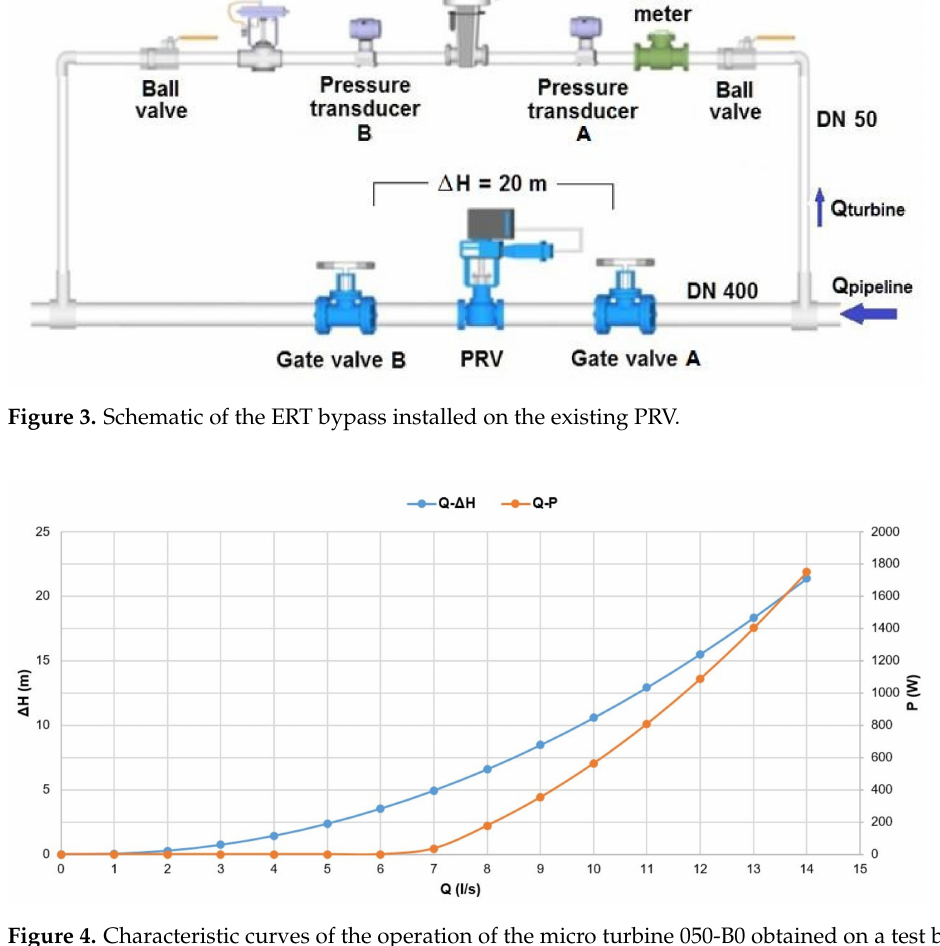
Figure 4. Characteristic curves of the operation of the micro turbine 050-B0 obtained on a test bench by the manufacturer (Tecnoturbines